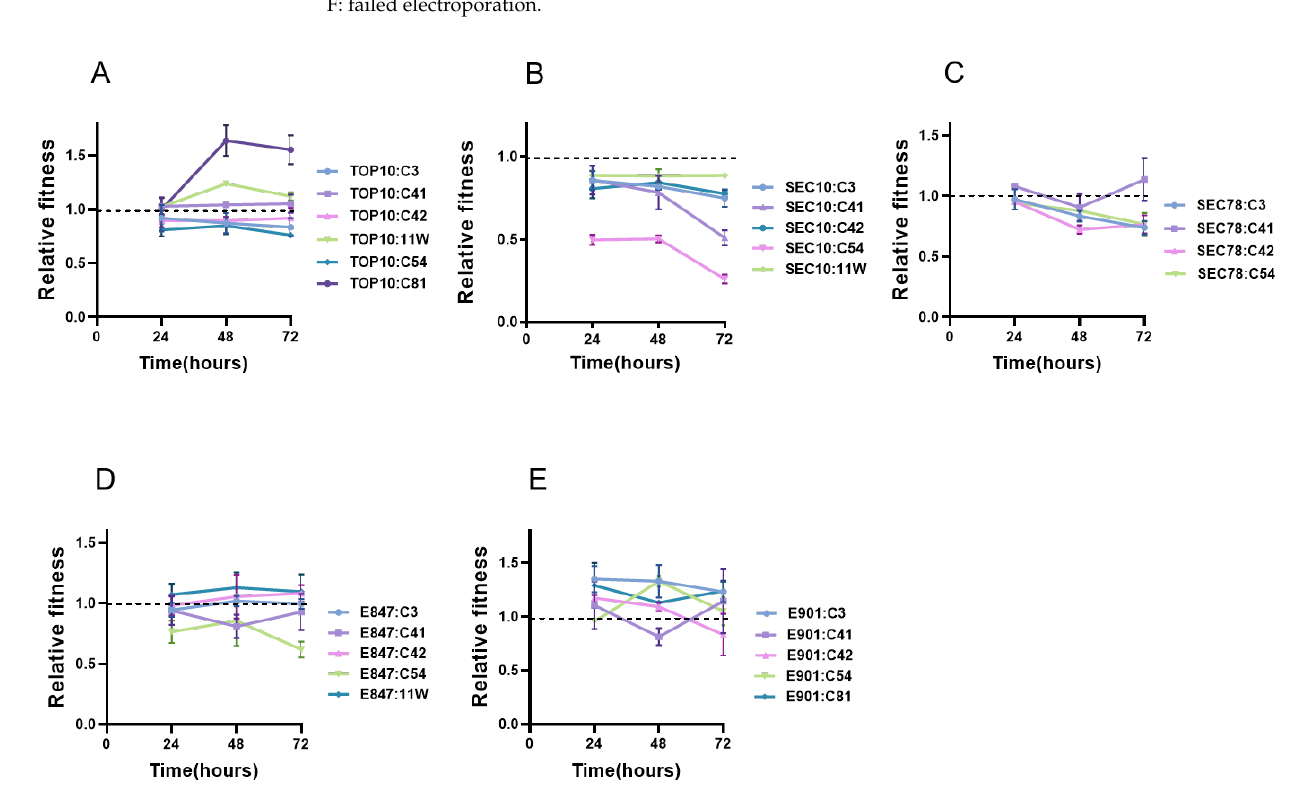
Figure 1. Relative fitness indices for 72 h of the transformants with their isogenic plasmid-free strains in this study. ( A ): Transformants of TOP10; ( B ): transformants of SEC10; ( C ): transformants of SEC78; ( D ): transformants of E847; ( E ): transformants of